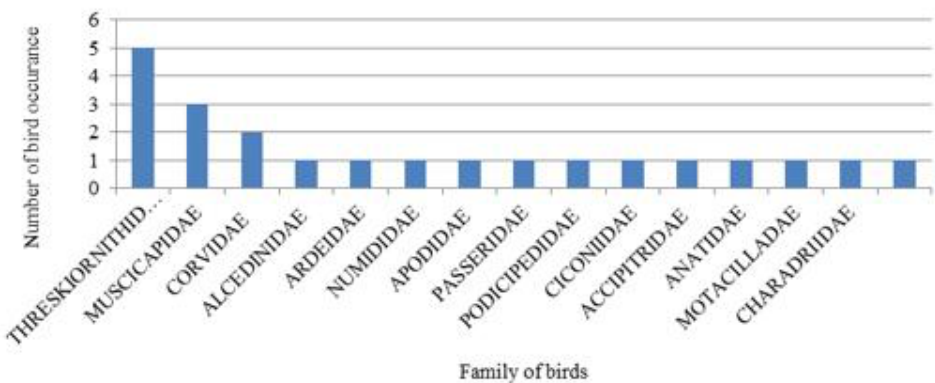
Fig. 3: The Family wise Number of bird on dumpsite and sewage stabilization